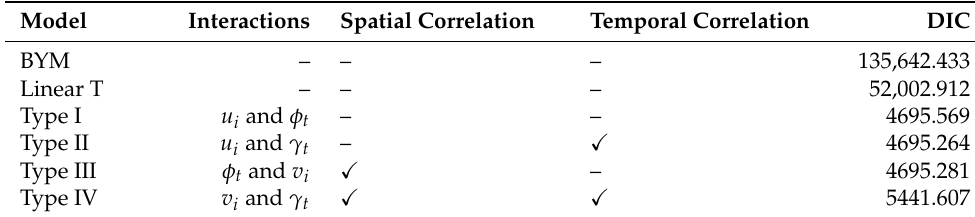
Table 1. DIC values for the spatial and spatio-temporal fitted